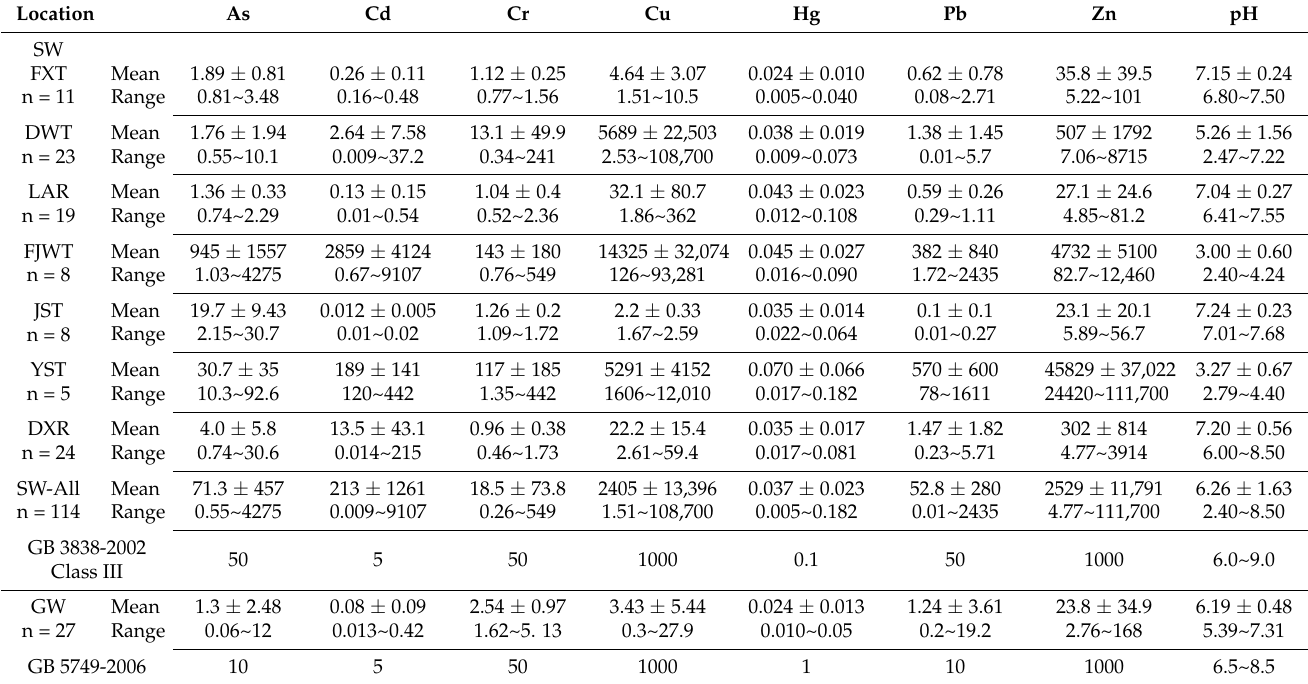
Table 2. Summary of the guideline values and statistics of HMs and pH in the surface and ground water samples.